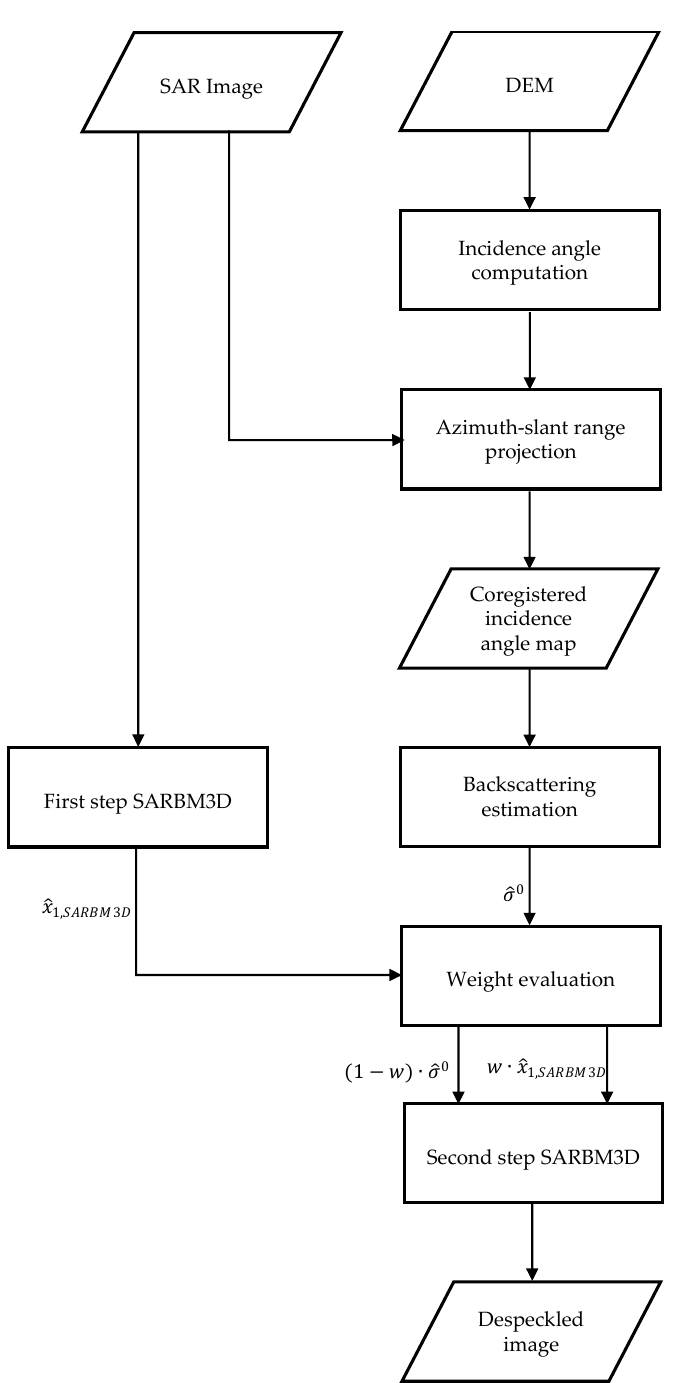
Figure 1. Block scheme of the Scattering-Based (SB)-SAR Block-Matching 3D (SARBM3D) algorithm.